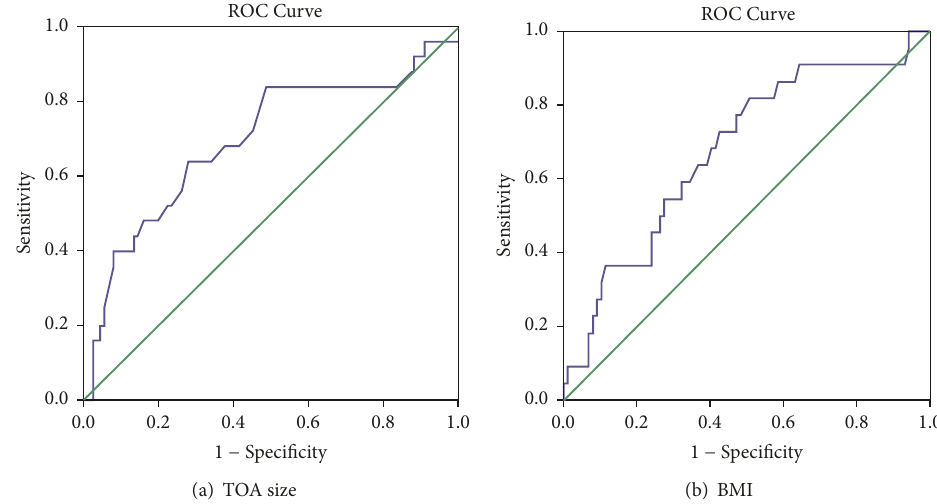
Figure 2: ROC curves to assess the usefulness of (a) TOA size and (b) BMI to predict failure of medical treatment with antibiotics in patients with